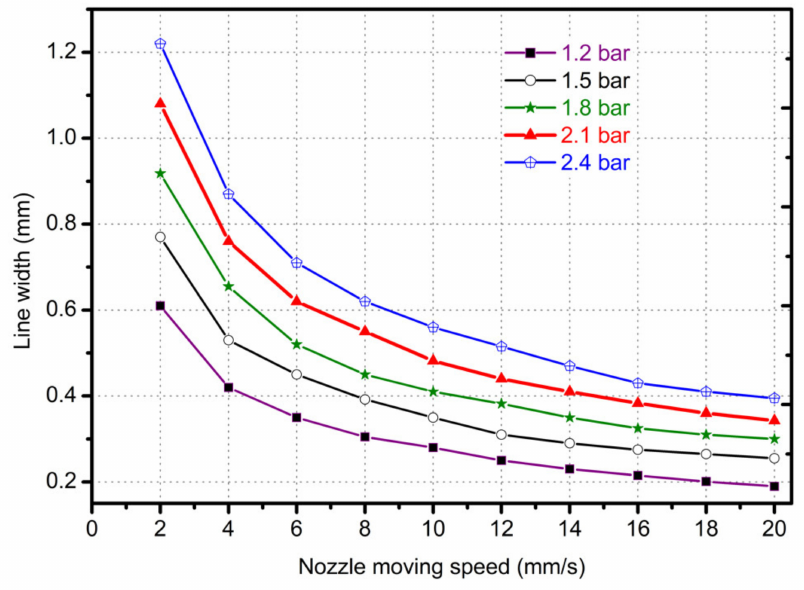
Figure 5. The line width with di ff erent nozzle moving in di ff erent pressures and moving speeds. For extrusion lines with the same line width, the porosity of sca ff olds varied with di ff erent fiber spacing. Setting the fiber interval in the range of 0.4–4 mm, other variables are maintained unchanged to simulate the printing conditions and parameters. Using a conical needle with an outlet diameter of 0.4 mm and setting the pressure of 1.8 bar and the needle speed of 10.7 mm / s, the relationship